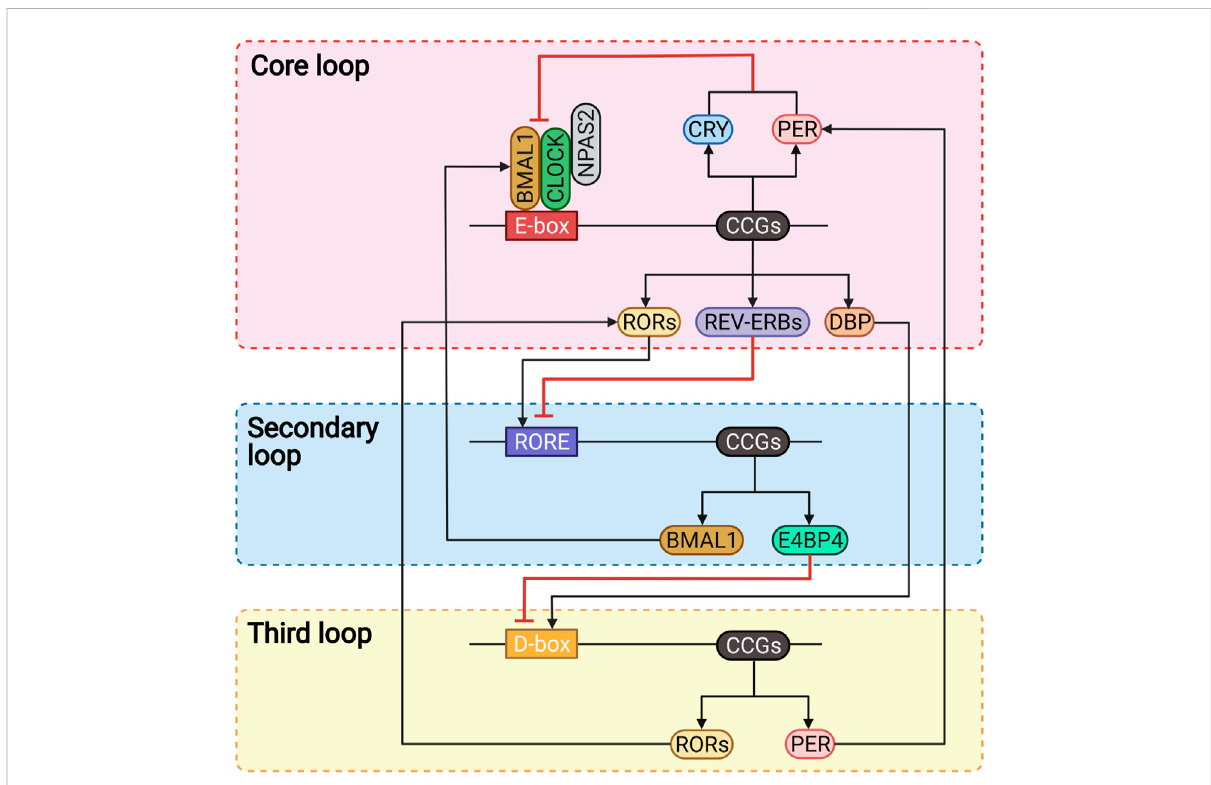
FIGURE 2 The molecular mechanism of human circadian rhythms. BMAL1, brain and muscle ARNT-like 1; CCGs, clock-controlled genes; CLOCK, circadian locomotor output cycles kaput; CRY, cryptochrome; DBP, D-box binding protein; E4BP4, E4 promoter-binding protein 4; NPAS2, neuronal PAS domain-containing protein 2; PER, period; RORE, ROR/REV-ERB response elements; RORs, retinoic acid receptor-related orphan